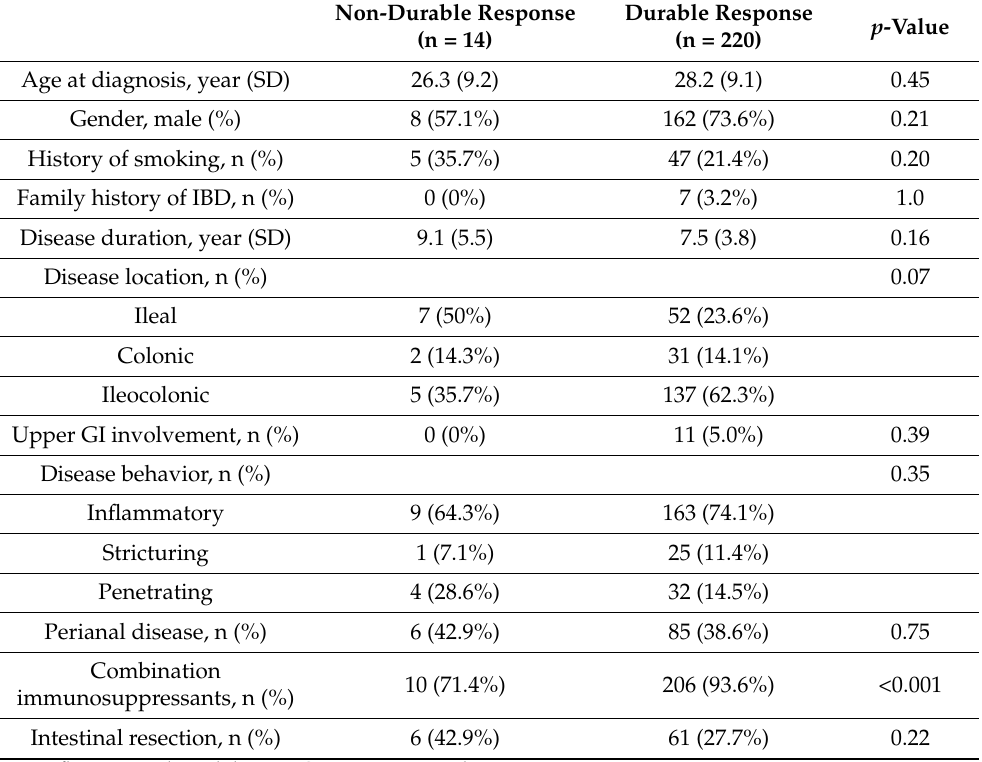
Table 1. Patients’ clinical